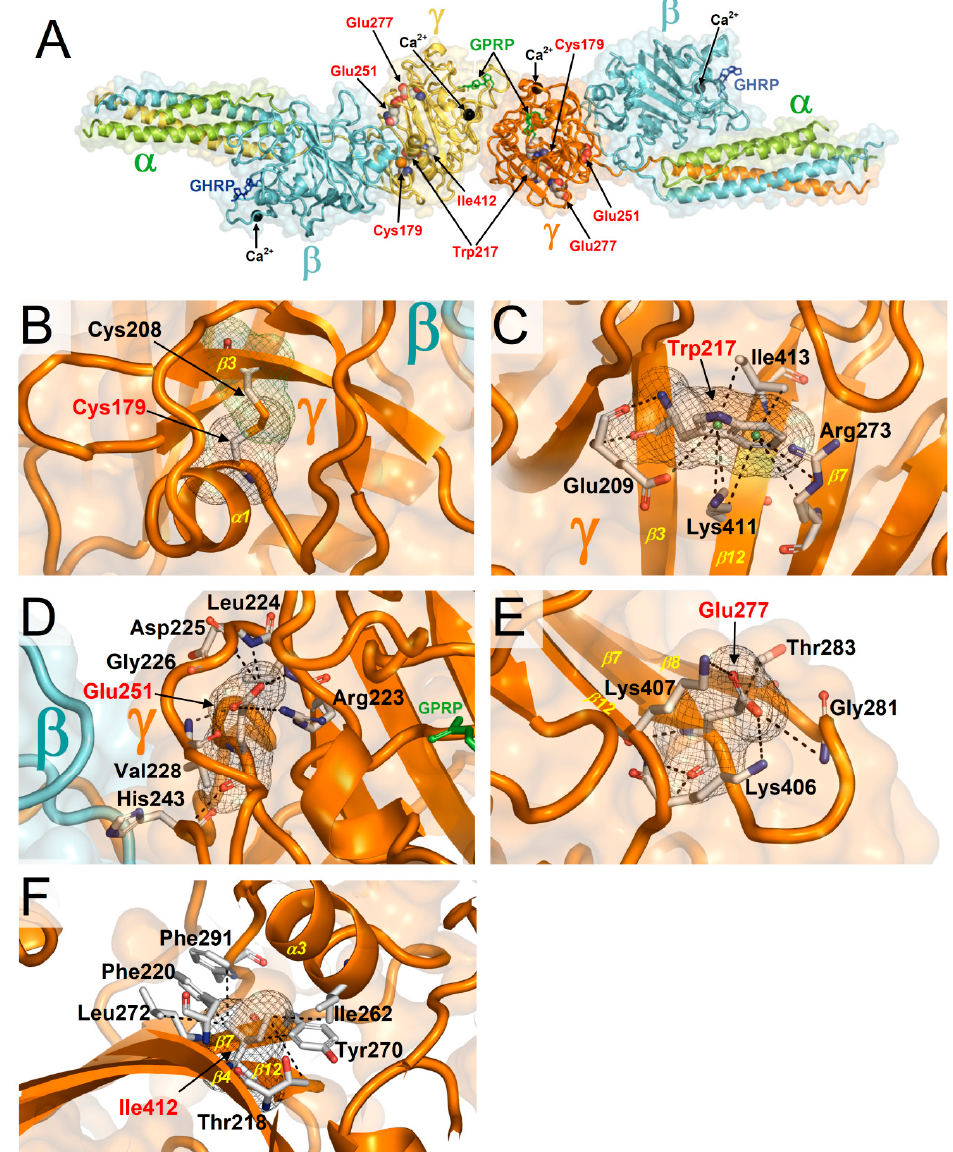
Figure 4. Amino acids a ff ected by the missense variants p.Cys179Phe, p.Trp217Gly, Glu251Gly, p.Glu277Gly, and p.Ile412Thr selected among those reported by gnomAD and consistently predicted by FoldX, CUPSAT, and PoPMuSiC to destabilize significantly the γ -module structure. ( A ) The wild type residues are shown on the crystal structure of fragment double-D from human fibrin (PDB 1FZC). GPRP is an analog of the α chain knob. GHRP represents the β chain knob. ( B ) Detailed view of the site of the p.Cys179Phe variant. The wild type cysteine 179 forms a disulfide bond with cysteine 208 in the core of the γ -module. The non-conserved replacement by phenylalanine is expected to cause misfolding. ( C ) The p.Trp217Gly replacement is also non-conserved, it causes the loss of several intramolecular interactions holding together various β strands in the γ -module core and is expected to cause misfolding. ( D ) The non-conserved p.Glu251Gly substitution causes the loss of multiple intramolecular interactions and is expected to cause severe structural changes in the γ -module. ( E ) The non-conserved p.Glu277Gly replacement disrupts multiple intramolecular interactions necessary to tighten various β strands and is predicted to cause important structural alteration. ( F ) The p.Ile412Thr variant a ff ects isoleucine engaged in several hydrophobic interactions contributing to the γ -module fold. The non-conserved replacement with a threonine is expected to misfold the module. In the detailed views, the interactions between the a ff ected wild type residues and surrounding residues contributing to the fold of the γ -module, are indicated by dotted